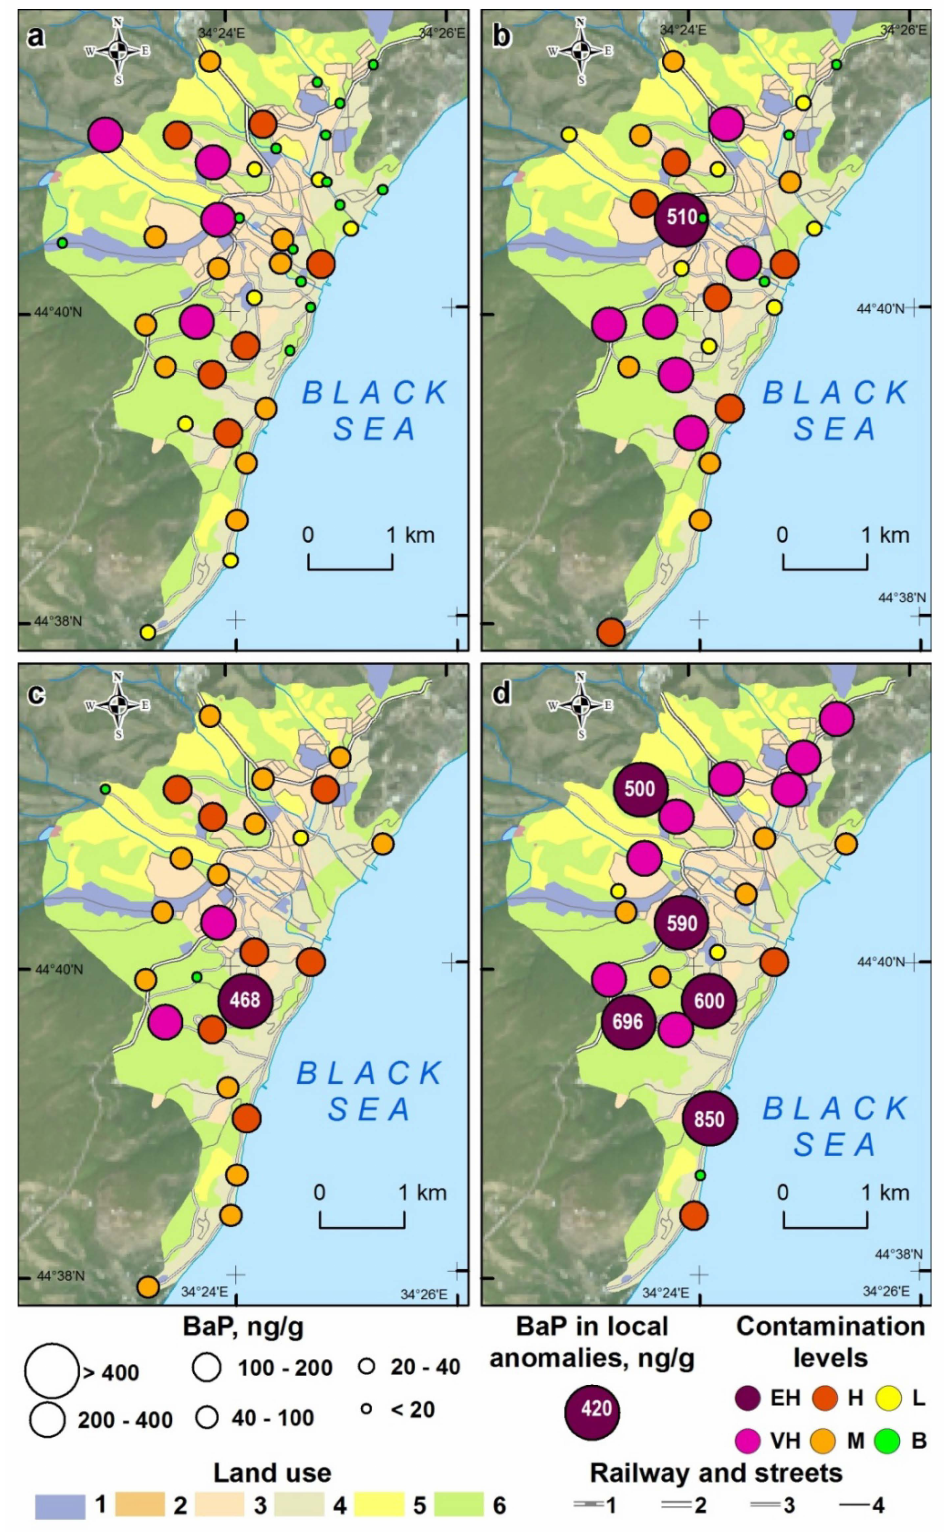
Figure 3. Distribution of BaP in soils ( a ) and their PM 10 particles ( b ), road dust ( c ) and its PM 10 particles ( d ) within the territory of Alushta. Contamination levels: EH—extremely high, VH— very high, H—high, M—moderate, L—low, B—background. Land use zones: 1—industrial, 2— multi-storey residential, 3—low-rise residential, 4—residential and recreational, 5—agrogenic, 6— recreational. Railway (1) and streets with: 2—large roads, 3—medium roads, 4—small